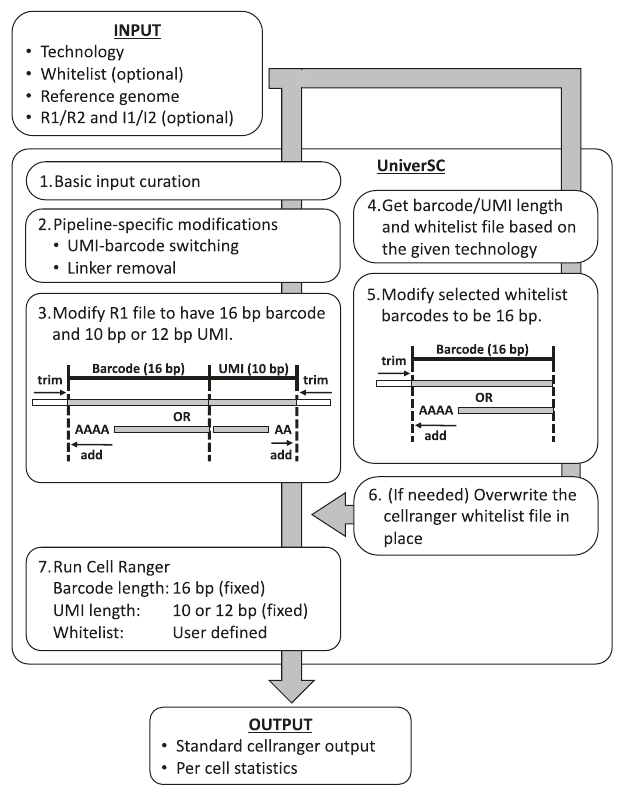
Fig. 1 | Overview of UniverSC. Given a pair of FASTQ fi les (R1 and R2), a genome reference (as required by Cell Ranger), and the name of the technology, UniverSC fi rstrunsabasicinputcuration(step-1).Thecuratedinput fi lesarethenadjustedfor pipeline-speci fi c modi fi cation (step-2) and subsequently reformatted to matchthe expectedbarcodeandUMIlengths(step-3).Inparallel,thebarcodewhitelistsuited for the technology (if unspeci fi ed by the user) is determined (step-4), and the whitelistbarcodesaremodi fi edto16bp(step-5).Iftheselectedwhitelistisdifferent from the whitelist in place for Cell Ranger at the moment, the whitelist is replaced (step-6). Finally, the modi fi ed sample data is processed by Cell Ranger against the modi fi edwhitelist(step-7)togenerateastandardoutputalongwithasummary fi le with per cell